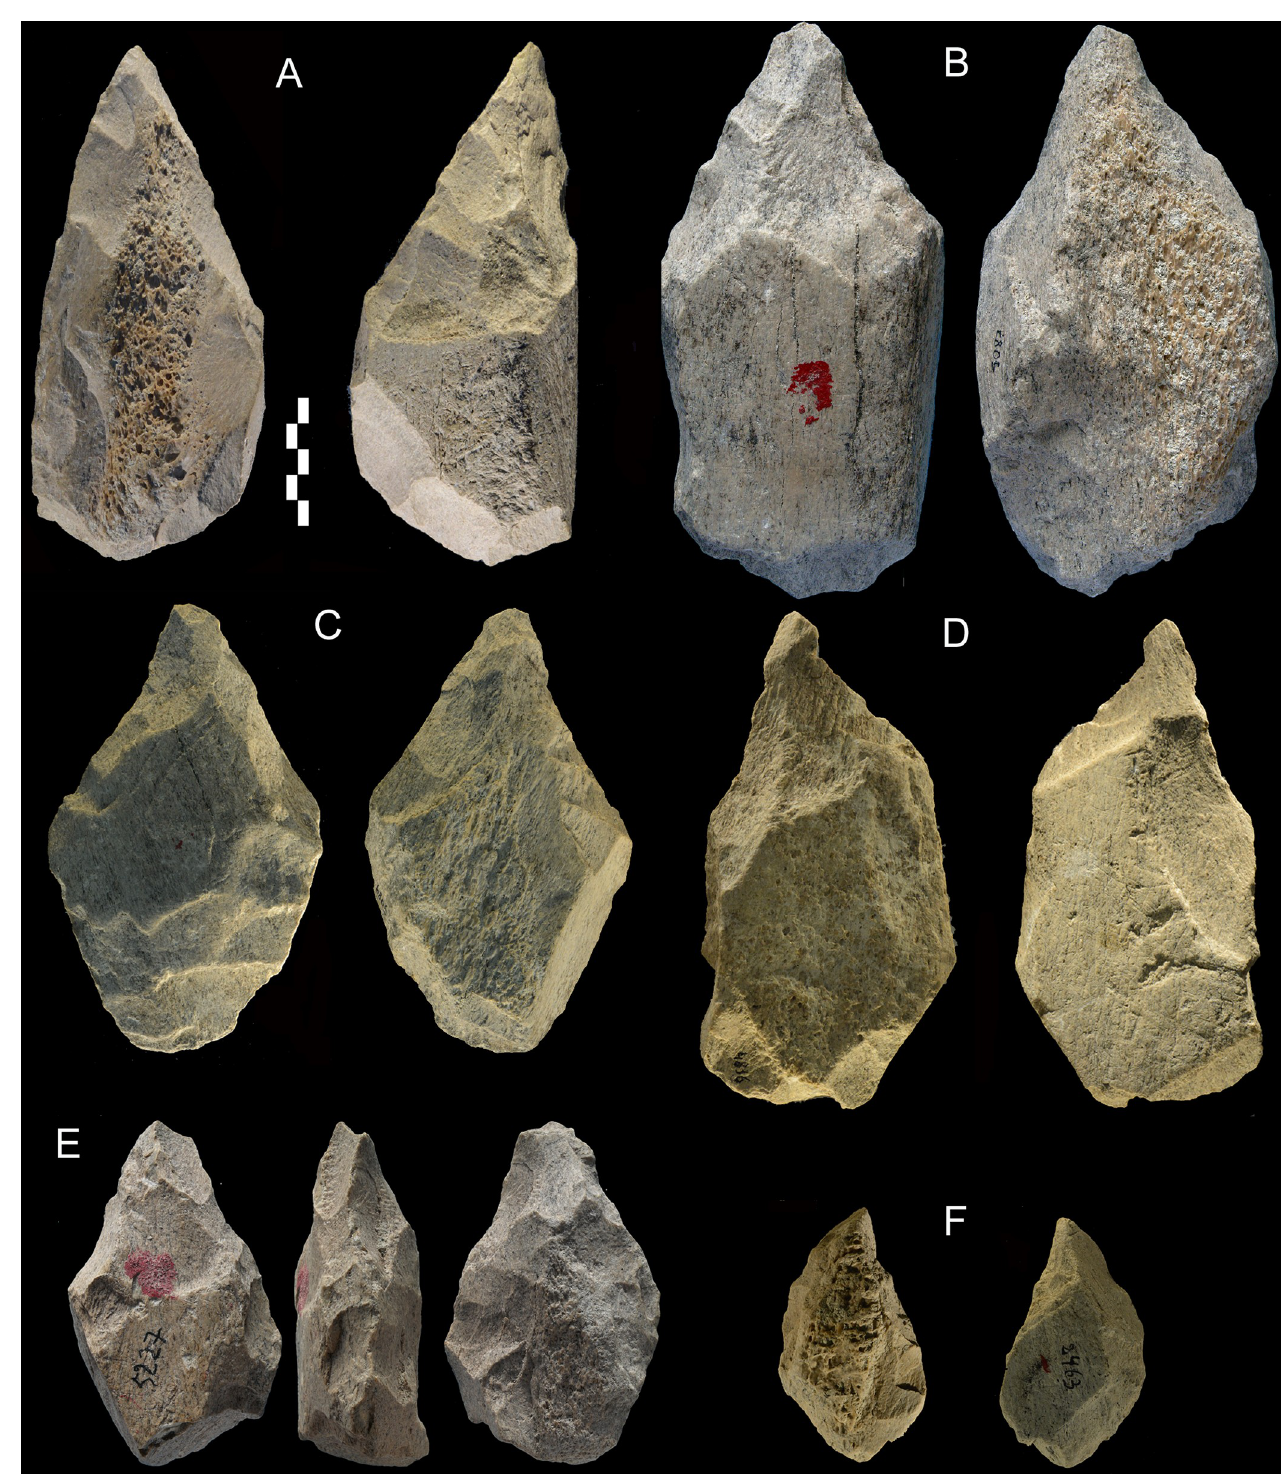
Fig 7. Castel di Guido, bifaces made on diaphysis fragments. Catalogue numbers (following the letter order) 1014, 5087, 5089, 4836, 5227, 2463. A and F are only slightly abraded, B-E have abraded and fresh removals on the same face, suggesting reuse (S4 Table in S1 File). Scale bar 5 cm.